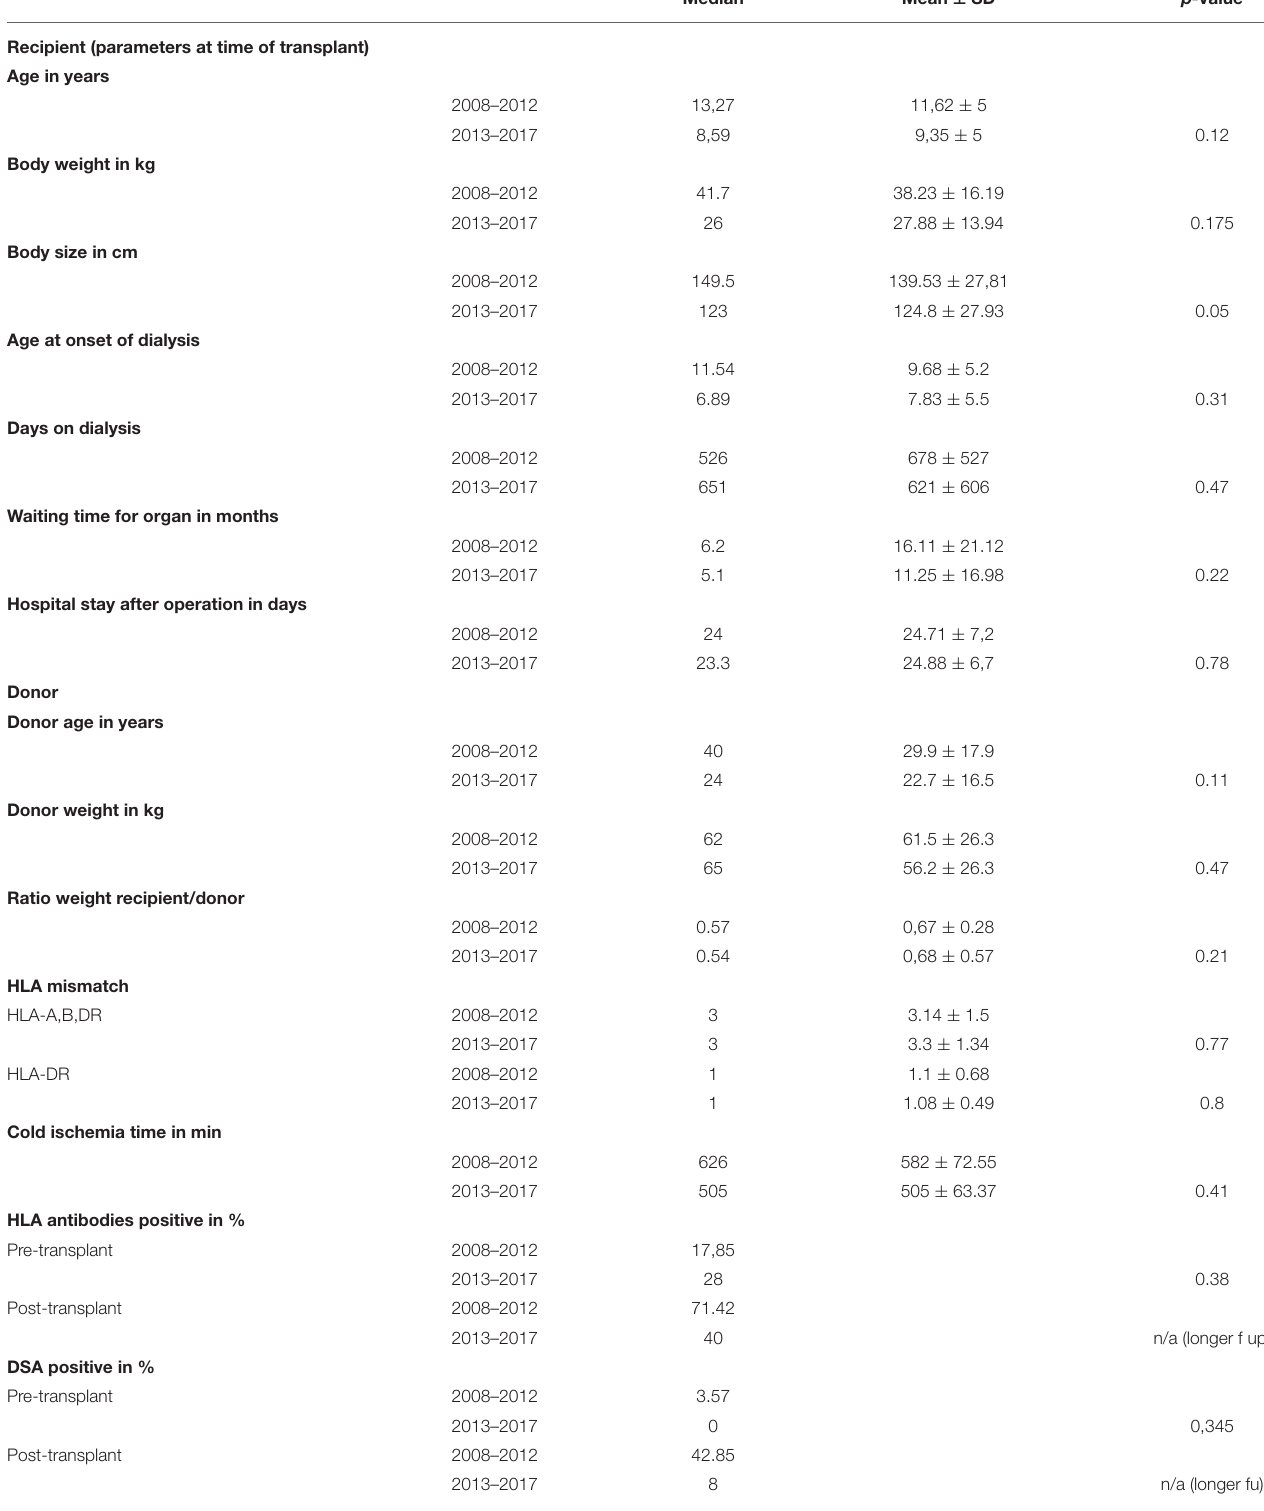
Median Mean ± SD p-